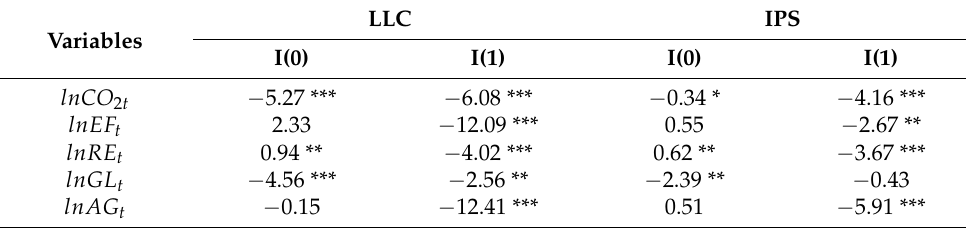
Table 3. Unit root